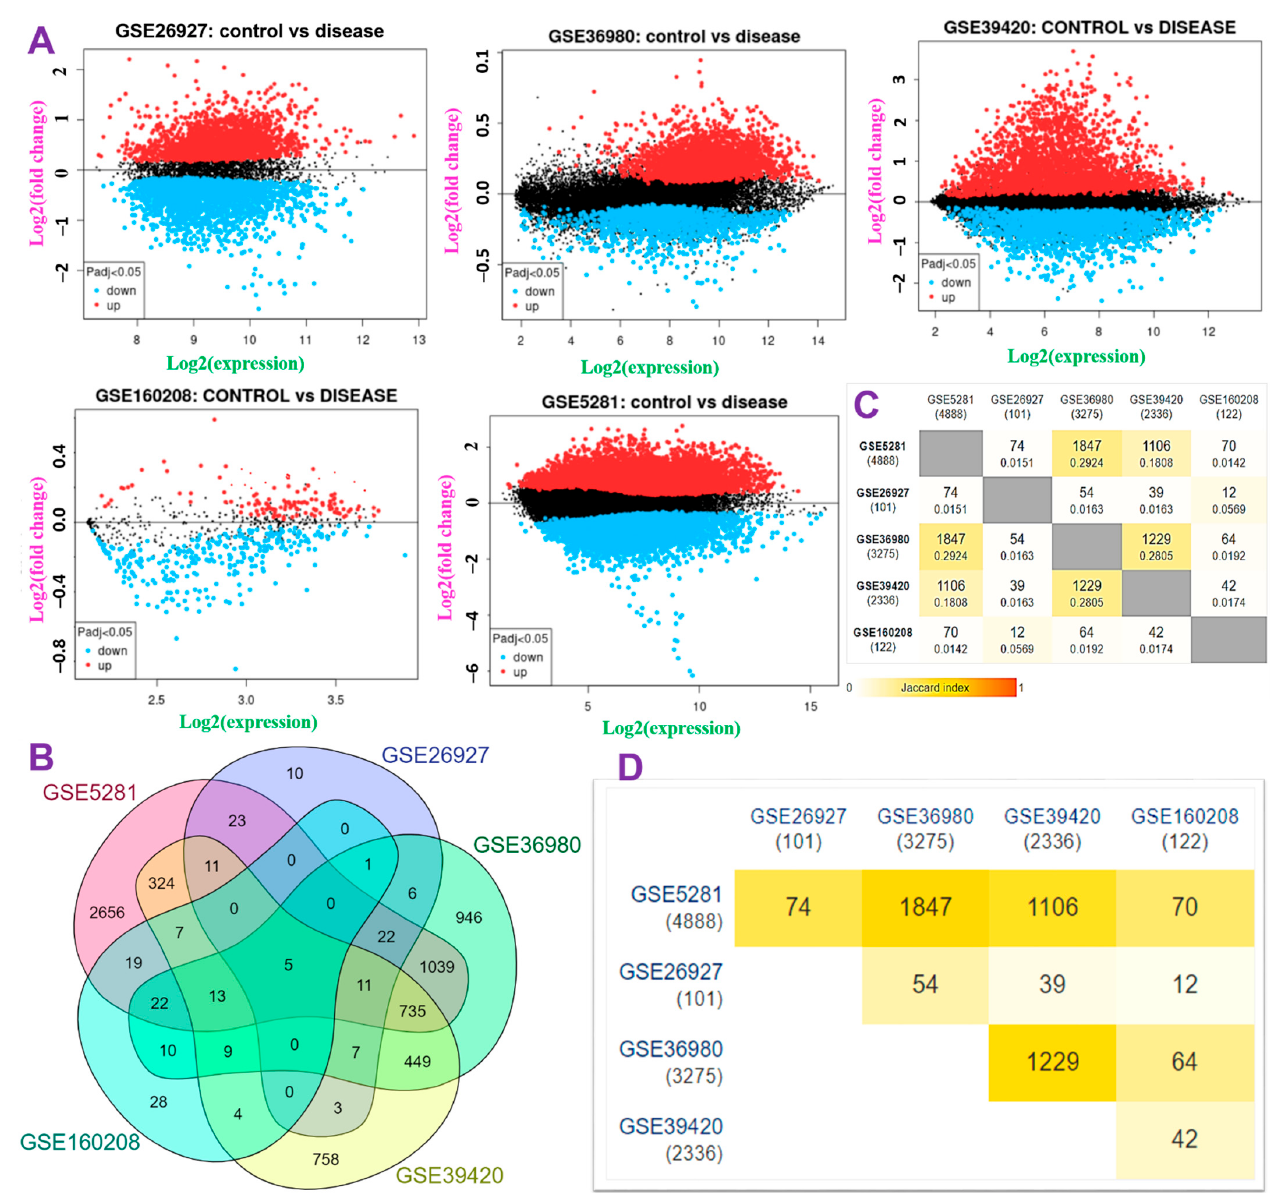
Figure 2. Identification of differentially expressed genes (DEGs) among patients with Alzheimer’s disease (AD) and healthy controls. ( A ) Volcano plot showing distributions of DEGs among AD patients and healthy controls. The top DEGs satisfied the criteria of log(multiple of change (MC) value) and p < 0.05. ( B ) Venn diagram of the DEGs across the six datasets. ( C and D ) Heatmap showing the Jaccard index of the DEGs in each of the datasets.